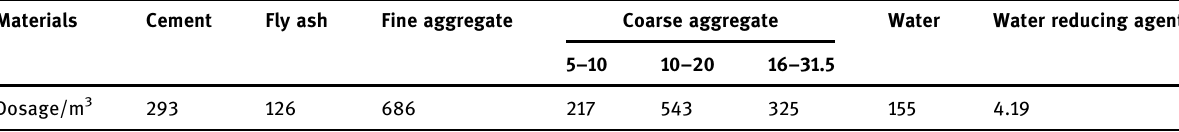
Table 4: C40 concrete mix proportion and material dosage ( kg/m 3 )